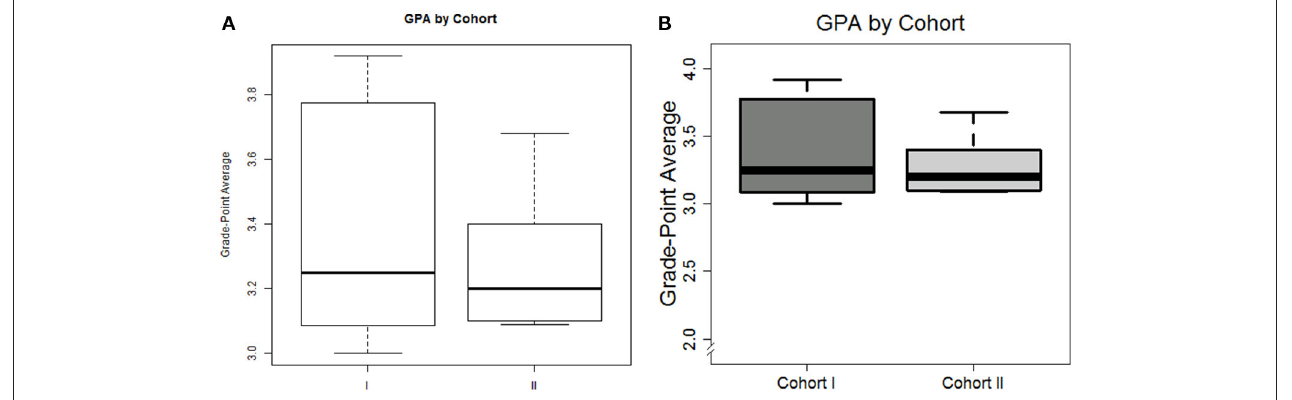
FIGURE 1 | Default plot (A) and modified plot (B) depicting the distribution of graduate GPA amongst non-compliant students in box plot format. plot are darkened, and shades of gray are added to the boxes; the title and axis label are re-positioned and